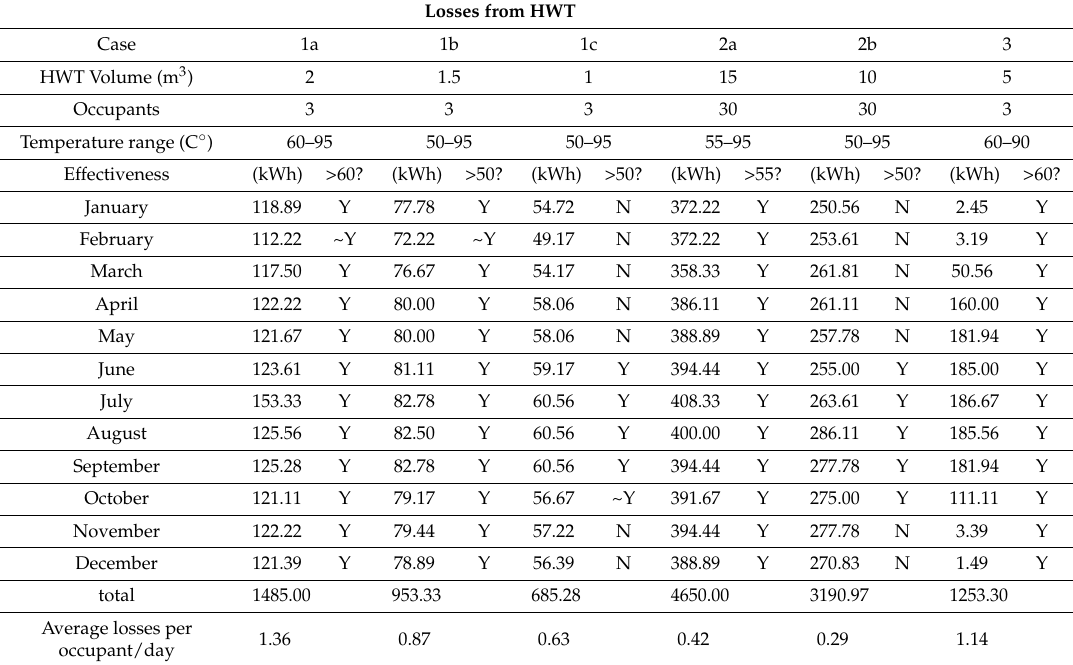
Table 5. Thermal energy losses (kWh) registered for every case considered in a year period.